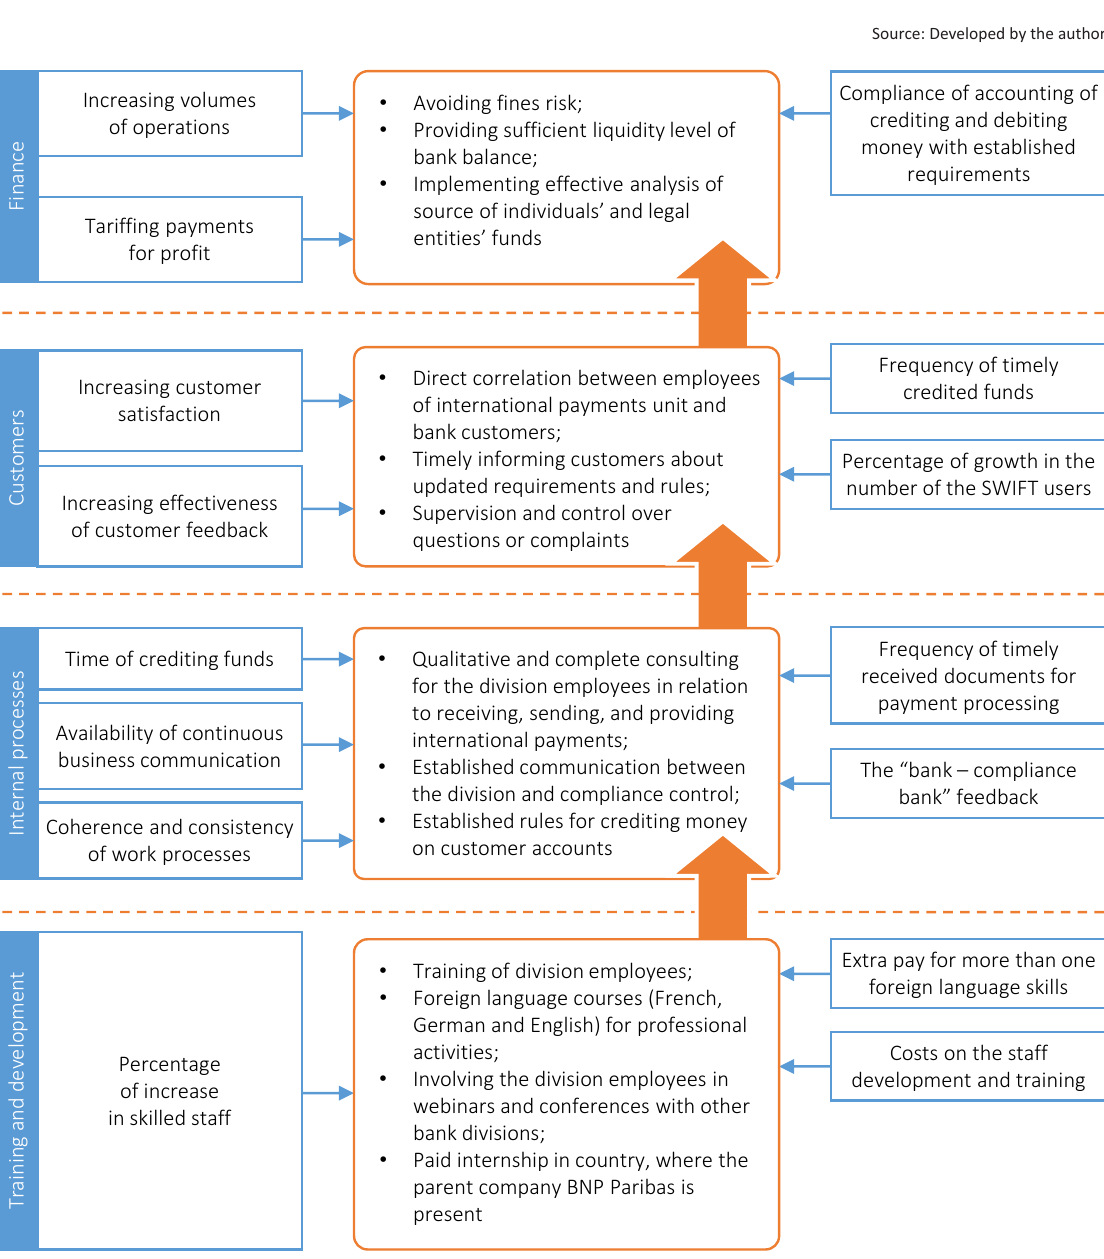
Figure 2. The strategy map for the international payments division of the operational payments department at